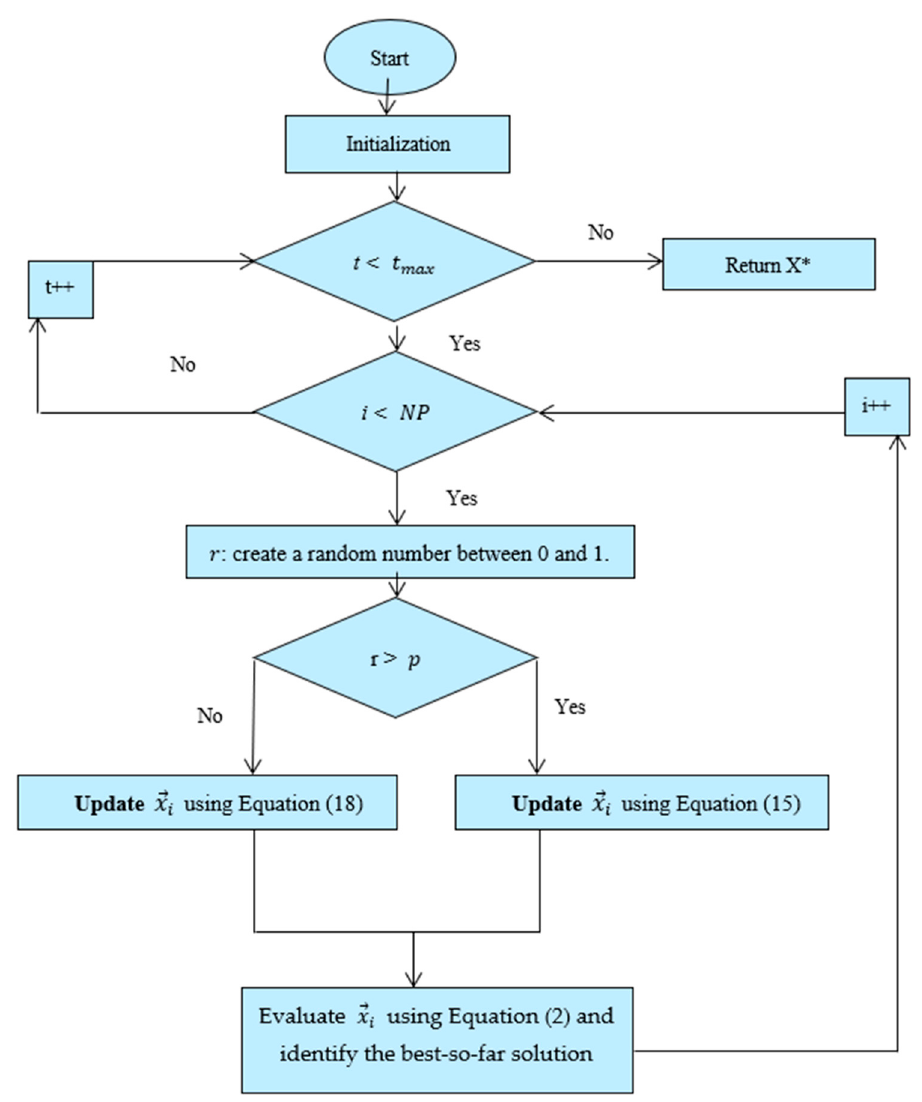
Figure 2. Flowchart of MFPA for tackling the NESs.